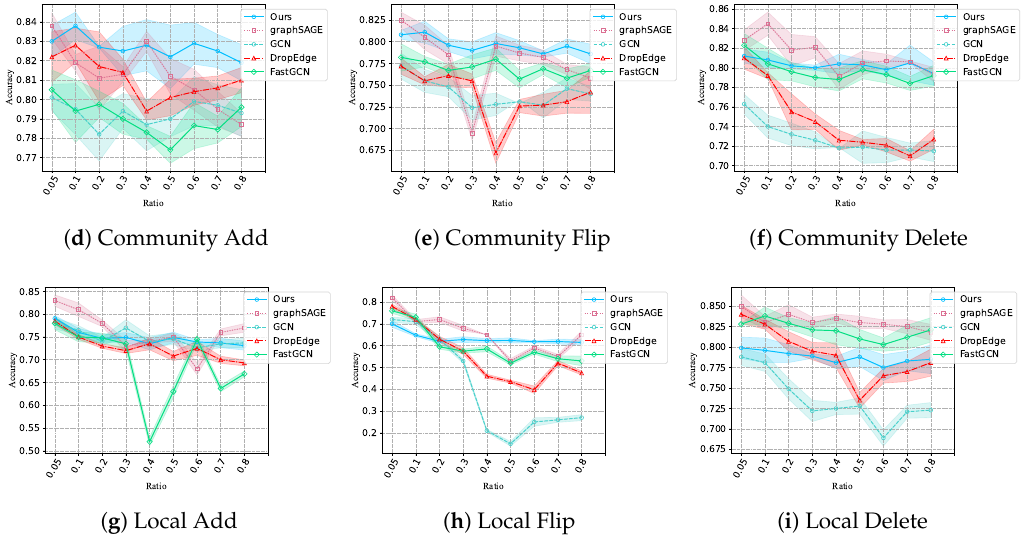
Figure 3. Overall performance of various models under various levels of structural noise. ( a – c ) depict global noise, ( d – f ) depict community noise, while ( g – i ) depict local noise. On the Cora dataset, we randomly delete, flip, or add edges to the original graph to create a corrupted graph and evaluate its performance. We set the ratio of modified edges to simulate attack intensities ranging from 0.05 to 0.8.